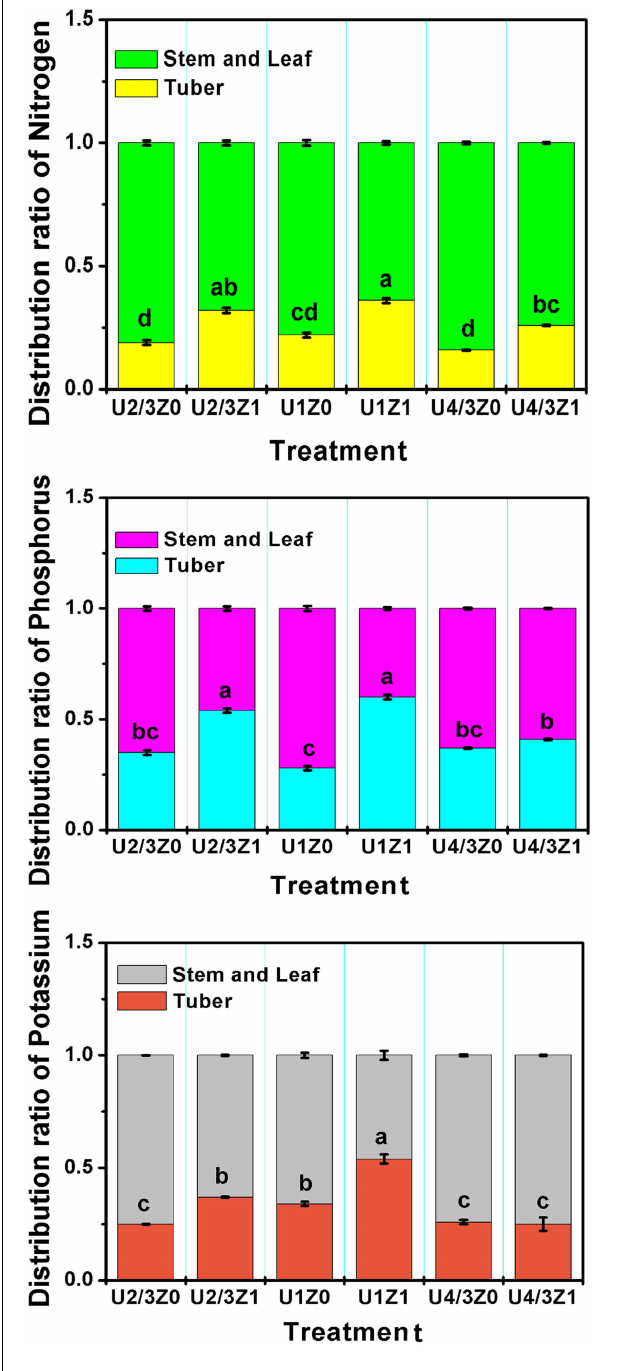
FIGURE 6 | Distribution coefficient of macroelements in potato tubers. Note: Means within each column followed by the same letter were not significantly different at the 0.05 level based on one-way ANOVAs followed by Duncan’s multiple range test.